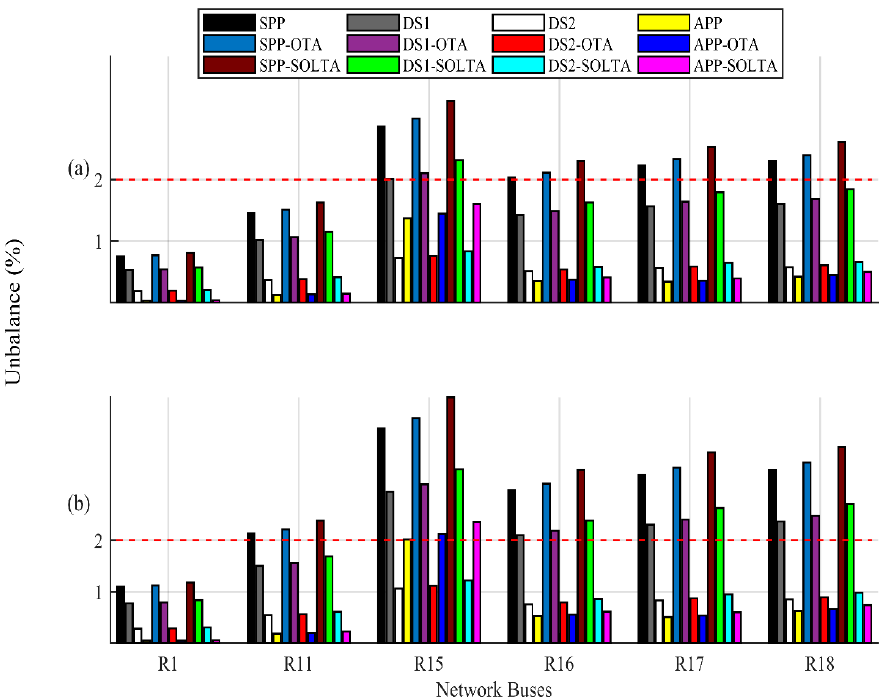
Figure 6. Voltage unbalance at distribution network buses with PV penetration levels: ( a ) 10% PV, ( b ) 15% PV .